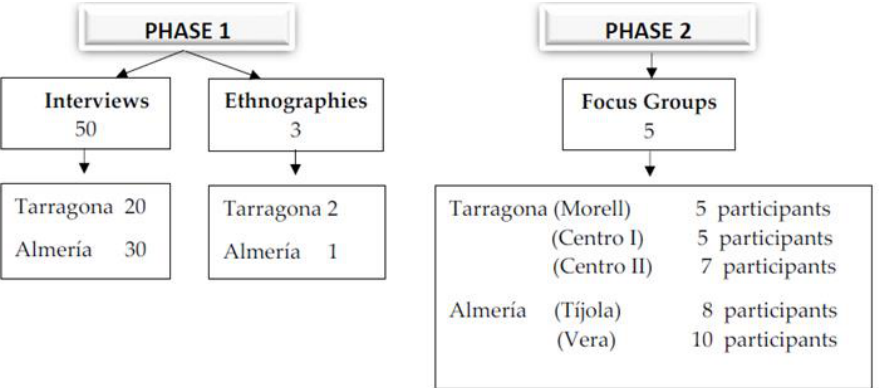
Figure 1. Data collection instruments by field work place.